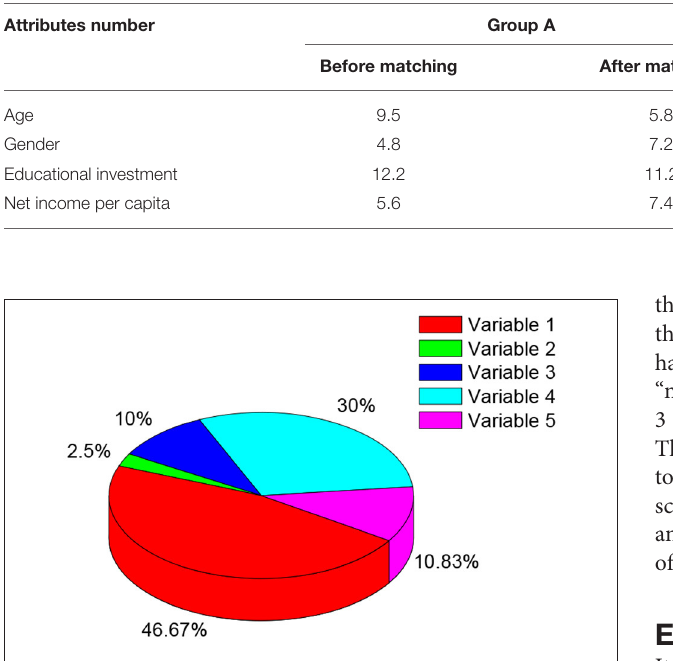
FIGURE 4 | Cognitive abilities distribution of left-behind children among the explained